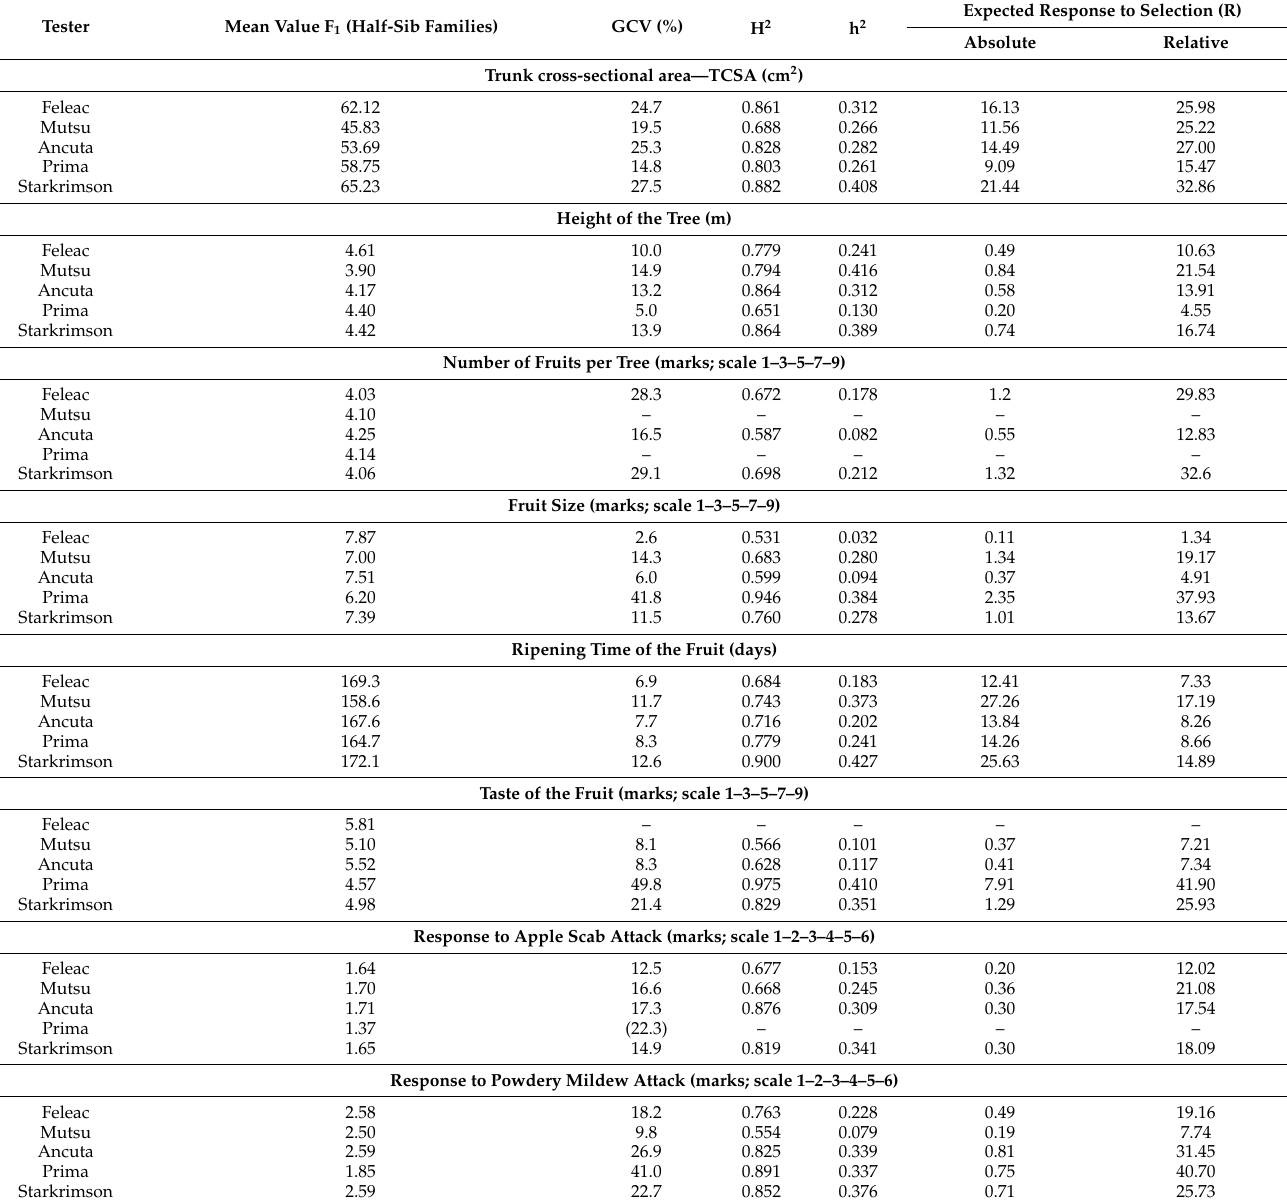
Table 9. Genetic parameters for traits analyzed in testcross combinations depending on